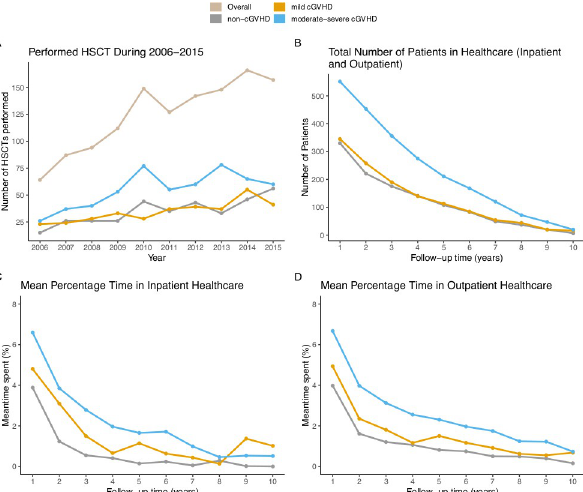
Fig 3. Healthcare resource utilization by cGVHD status among patients who survived � 6 months post-HSCT. (A) Number of HSCTs performed during 2006–2015. (B) Total number of patients in healthcare (inpatient and outpatient) per follow-up year. (C) Average proportion of time patients spent in inpatient healthcare per follow-up year. (D) Average proportion of time patients spent in outpatient healthcare per follow-up year.